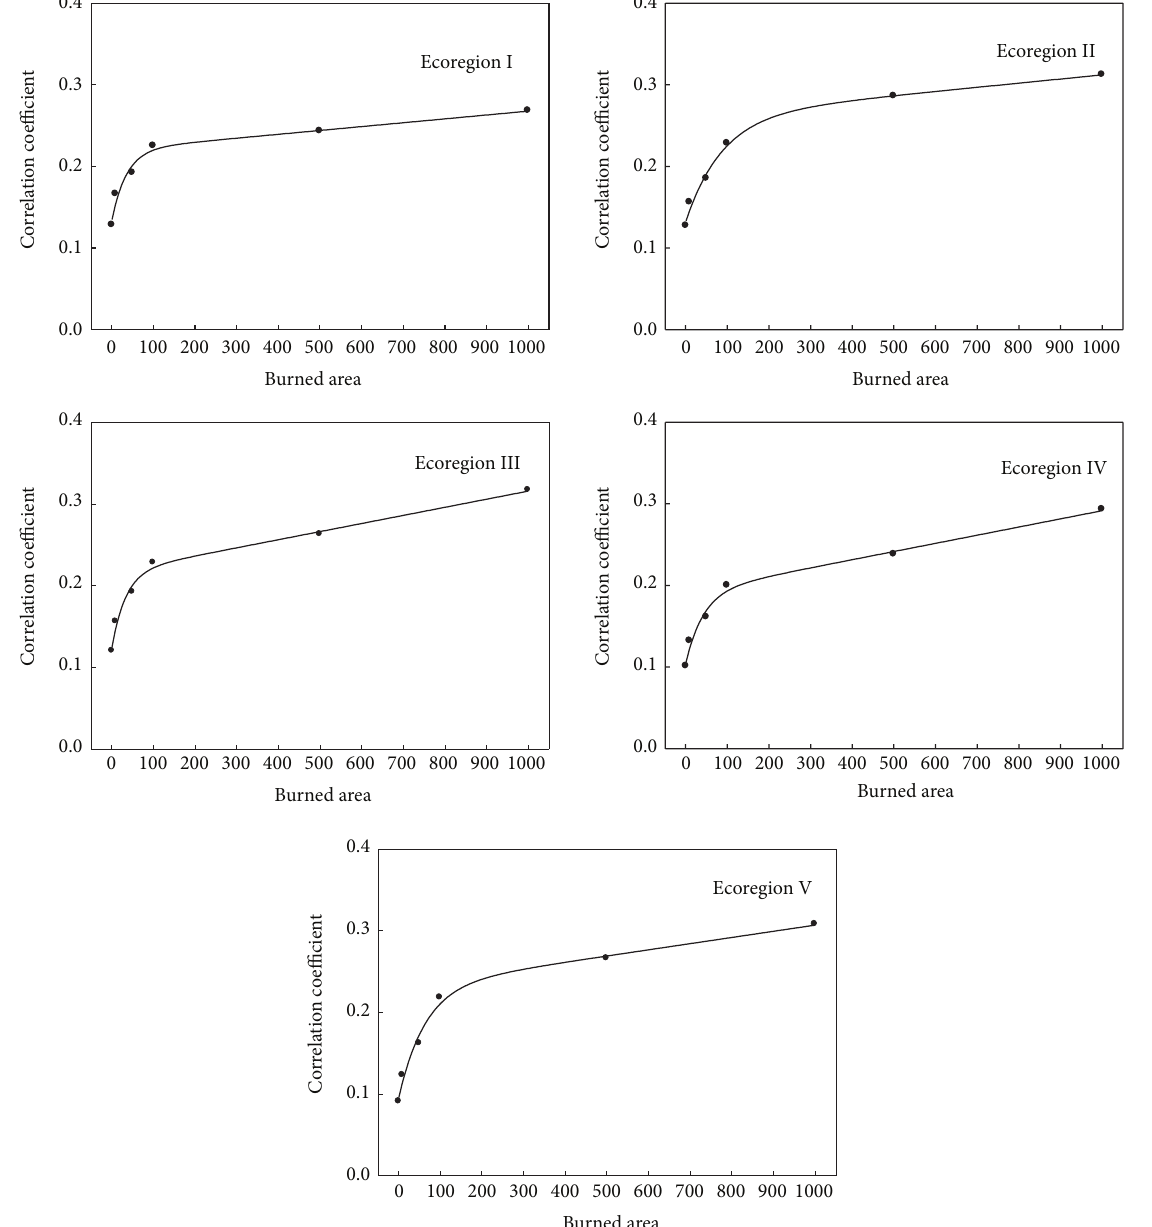
Figure 5: The change of correlation coefficients between long-transformed burned area and the number of consecutive dry days defined by the threshold daily rainfall amount (mm) by fire size group and ecoregion. The six fire size classes (represented by black dots) are < 1.0 (small fire), 1.0–9.9 (moderately small fire), 10.0–49.9 (moderate fire), 50.0–99.9 (moderately large fire), 100.0–500.0 (large fire), and 500–1000 (extremely large fire),